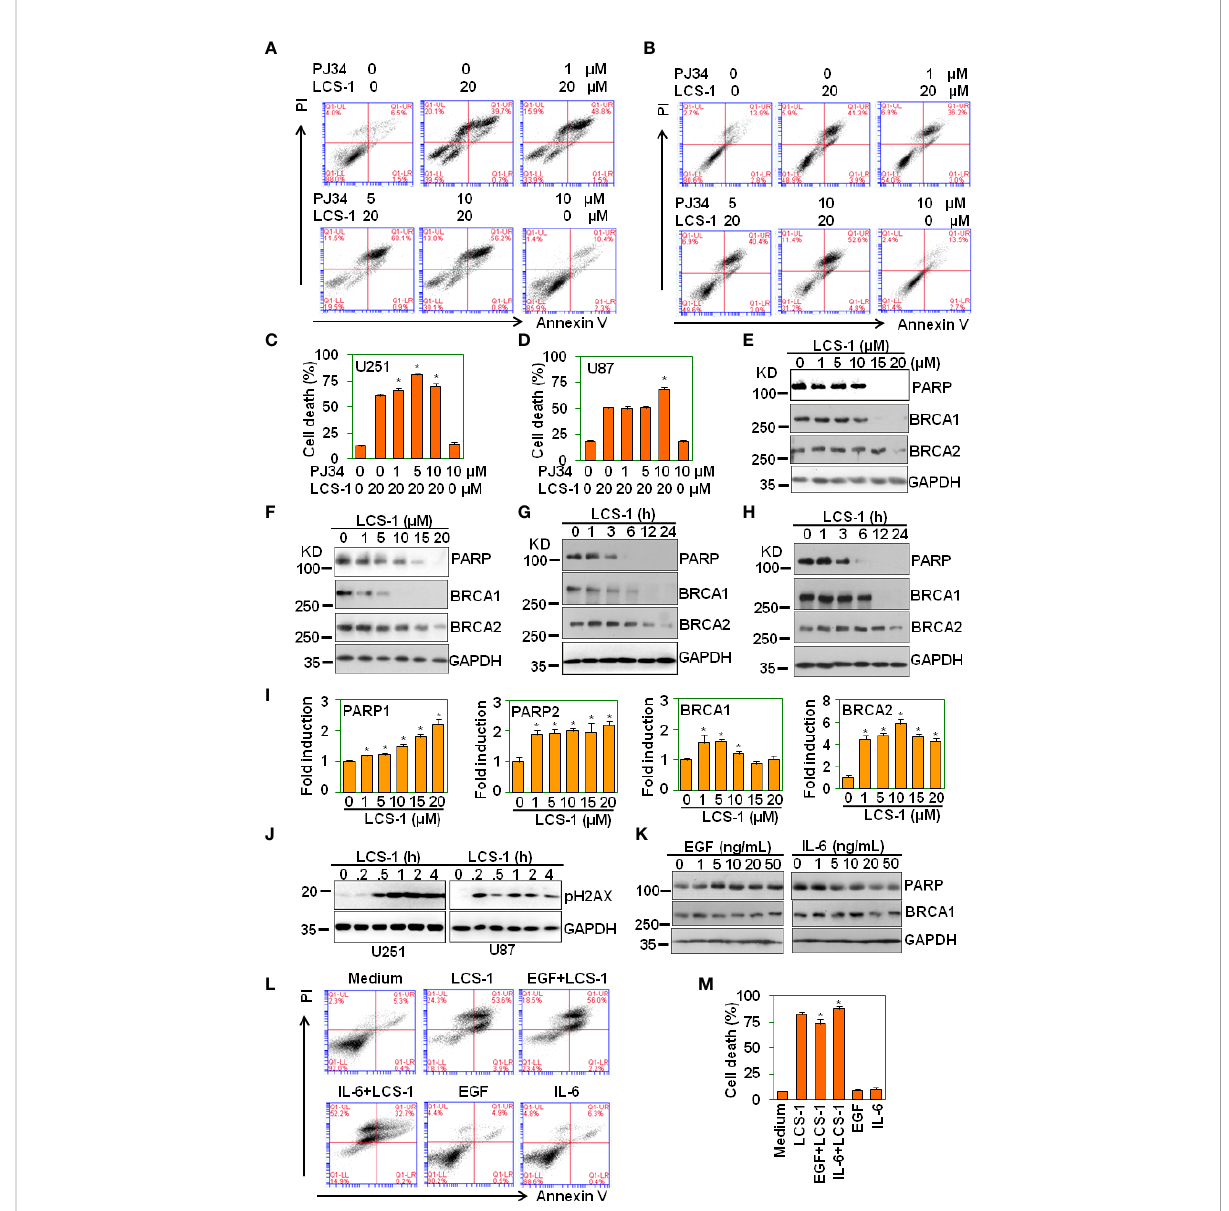
FIGURE 9 LCS-1 induces degradation of both PARP and BRCA1. (A) PI/FITC-Annexin V staining of death of U251 glioma cells pretreated with the indicated doses of PARP inhibitor PJ34 for 1 h. and retreated with 20 m M LCS-1 for 24 h (B) PI/FITC-Annexin V staining of death of U87 glioma cells pretreated with the indicated doses of PARP inhibitor PJ34 for 1 h. and retreated with 20 m M LCS-1 for 24 h. (C, D) Quantitative data of A (C) and B (D) respectively. * P < 0.05 compared with LCS-1-treated alone groups. (E, F) Western blot analysis of the protein levels of PARP, BRCA1 and BRCA2 in U251 (E) and U87 (F) cells treated with the indicated doses of LCS-1 for 24 h. GAPDH protein levels were measured as loading controls. (G, H) Western blot analysis of the protein levels of PARP, BRCA1 and BRCA2 in U251 (G) and U87 (H) cells treated with 20 m M LCS-1 for the indicated time periods. GAPDH protein levels were measured as loading controls. (I) qRT-PCR analysis of the mRNA levels of PARP1, PARP2, BRCA1 and BRCA2 in U251 cells treated with the indicated doses of LCS-1 for 12 h. * P < 0.05 compared with the control groups. (J) Western blot analysis of the phosphorylated levels of H2AX in U251 and U87 cells treated with 20 m M LCS-1 for the indicated time periods. GAPDH protein levels were measured as loading controls. (K) Western blot analysis of the protein levels of PARP, BRCA1 in U87 cells treated with the indicated doses of EGF, or IL-6 for 24 h. GAPDH protein levels were measured as loading controls. (L) PI/FITC-Annexin V staining of death of U87 glioma cells pretreated with 20 ng/mL EGF, or 20 ng/mL IL-6 for 24 h. and retreated with 20 m M LCS-1 for 24 h. (M) Quantitative data from L. * P < 0.05 compared with LCS-1-treated alone